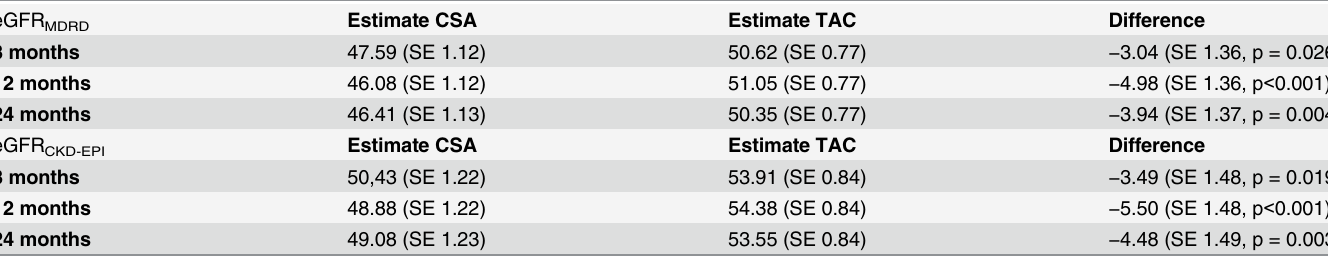
Table 2. Effect Comparison in linear mixed models for eGFR MDRD and eGFR CKD-EPI . eGFR